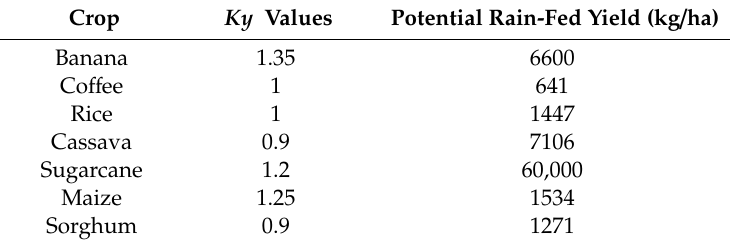
Table A3. Crop-yield response factors.